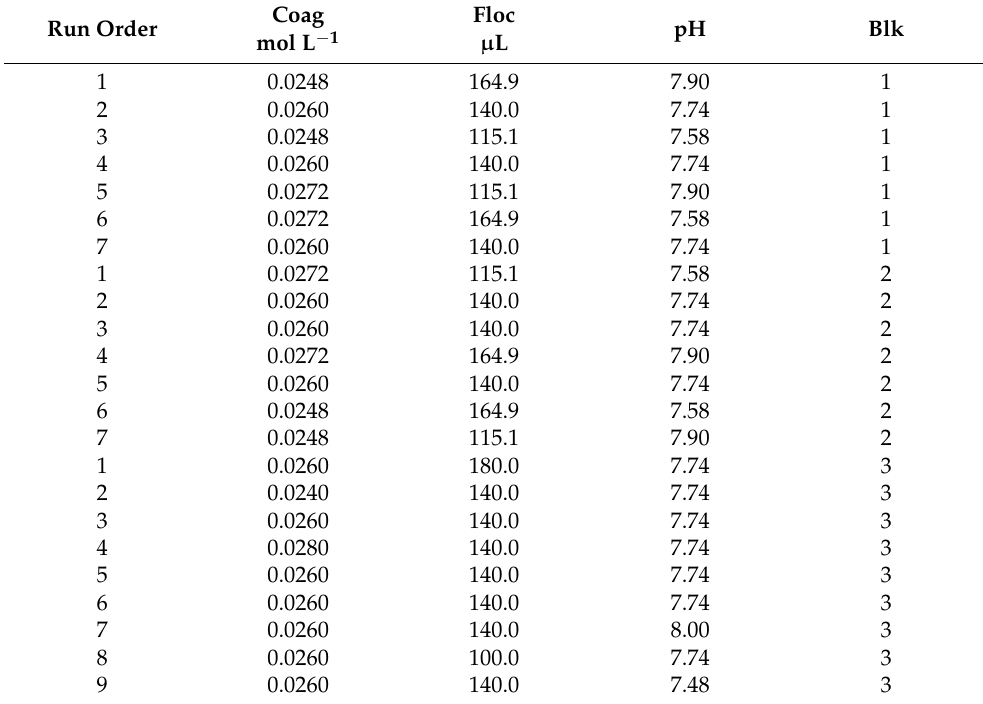
Table 3. Experiment design table results.